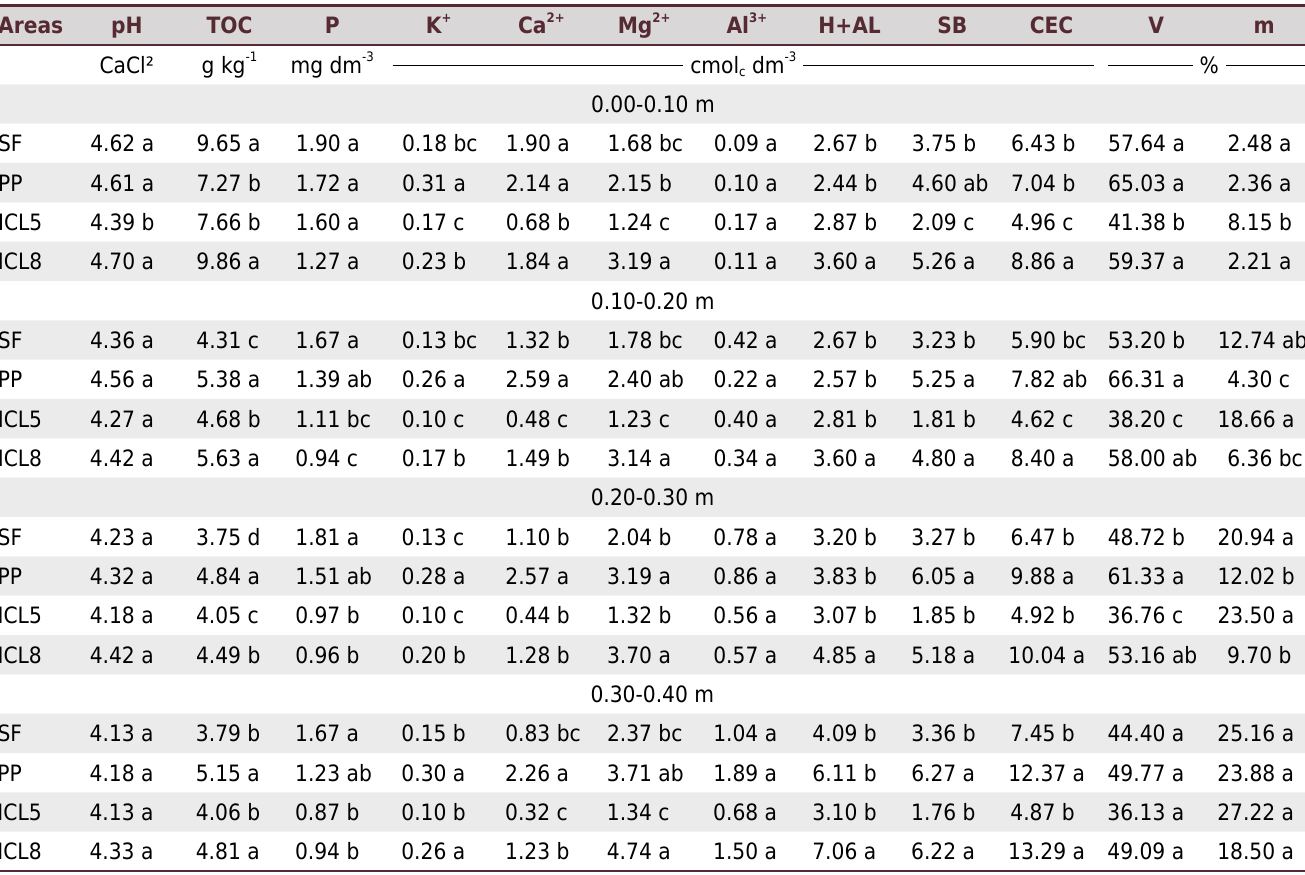
Table 3. Chemical properties of the Plintossolo Argilúvico under different managements in the Amazônia Maranhense Areas pH